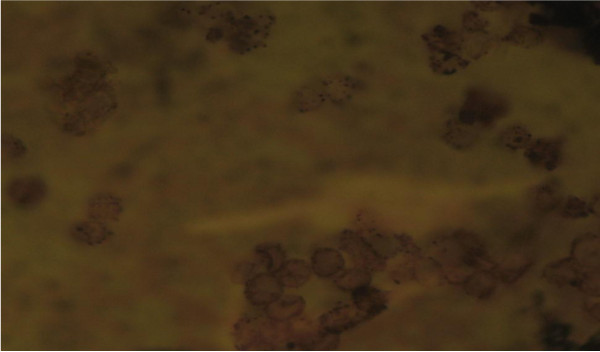
Picture of sickle cell patient blood treated with Ipomoea involucrata (Magnification: x1000).